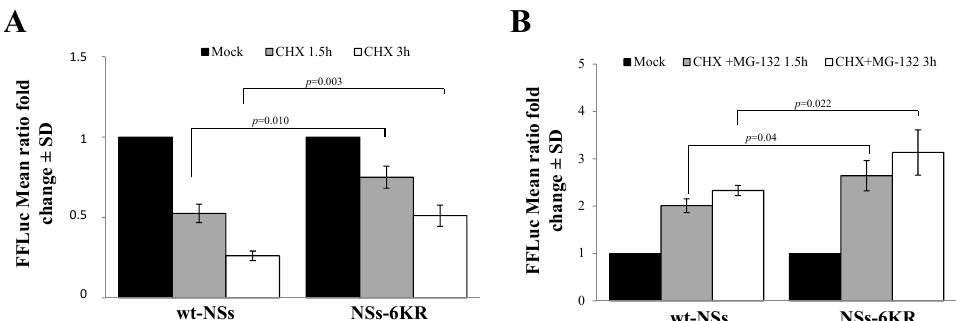
Figure 6. E ff ects of lysine residues in the core region on protein stability. ( A ) A new NSs mutant (NSs-6KR), consisting of arginine substitution at lysine 104, 108, 109, 150, 154, and 179 position, was generated and tested for protein stability. CHX chase experiments evidenced a significantly increased stability for the NSs mutant with respect to the wt-NSs protein. ( B ) The NSs-6KR mutant still responded to MG-132, as shown by the chase experiments. Transfected cells were treated with CHX in combination with 25 µ M of MG-132 and then residual luciferase activities were measured. Graphs represent mean values ± standard deviations (SD) of three independent experiments.